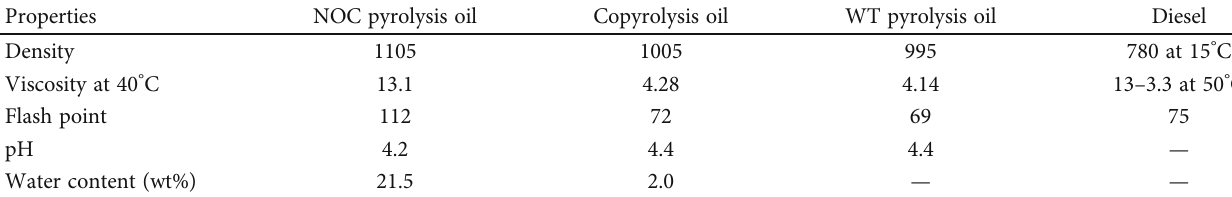
Table 2: Comparison of oil properties.